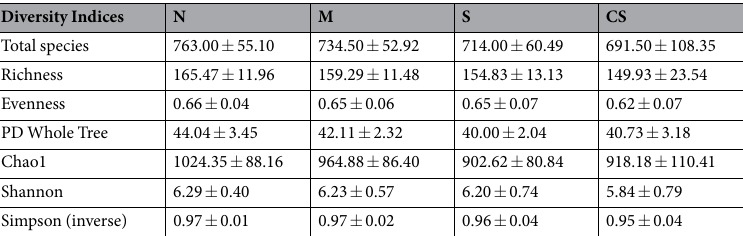
Table 1. Chondroitin sulfate disaccharides as a supplement did not appear to affect gut microbial diversity in mice. N: healthy mice + PBS; M: mice subjected to exhaustive exercise stress + PBS; CS: healthy mice supplemented with a daily dose of 150 mg/kg bodyweight of CS disaccharides for 16 days. S: the stressed mice supplemented with a daily dose of 150 mg/kg bodyweight of CS disaccharides for 16 days. The numbers represented mean ±